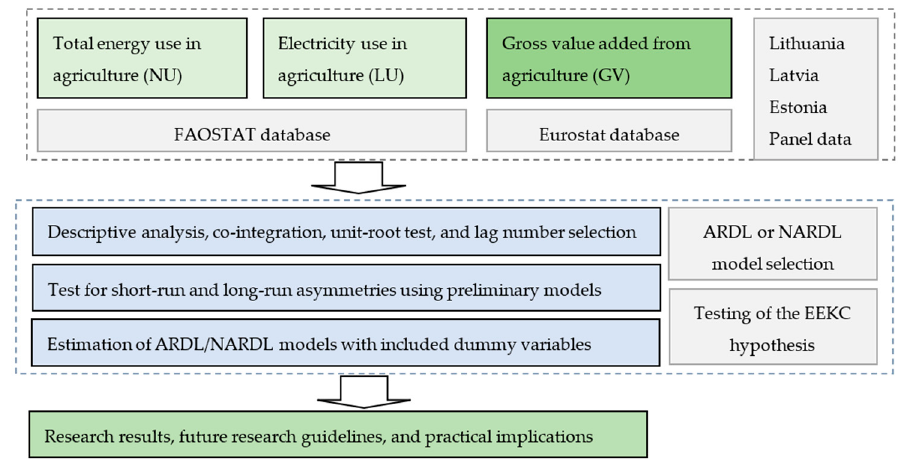
Figure 1. The study’s research